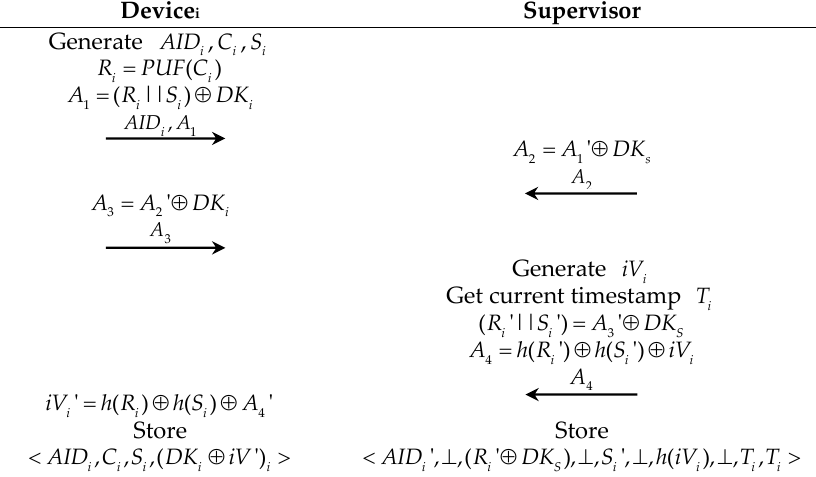
Figure 2. PEASE protocol steps in the registration phase (secure channel).